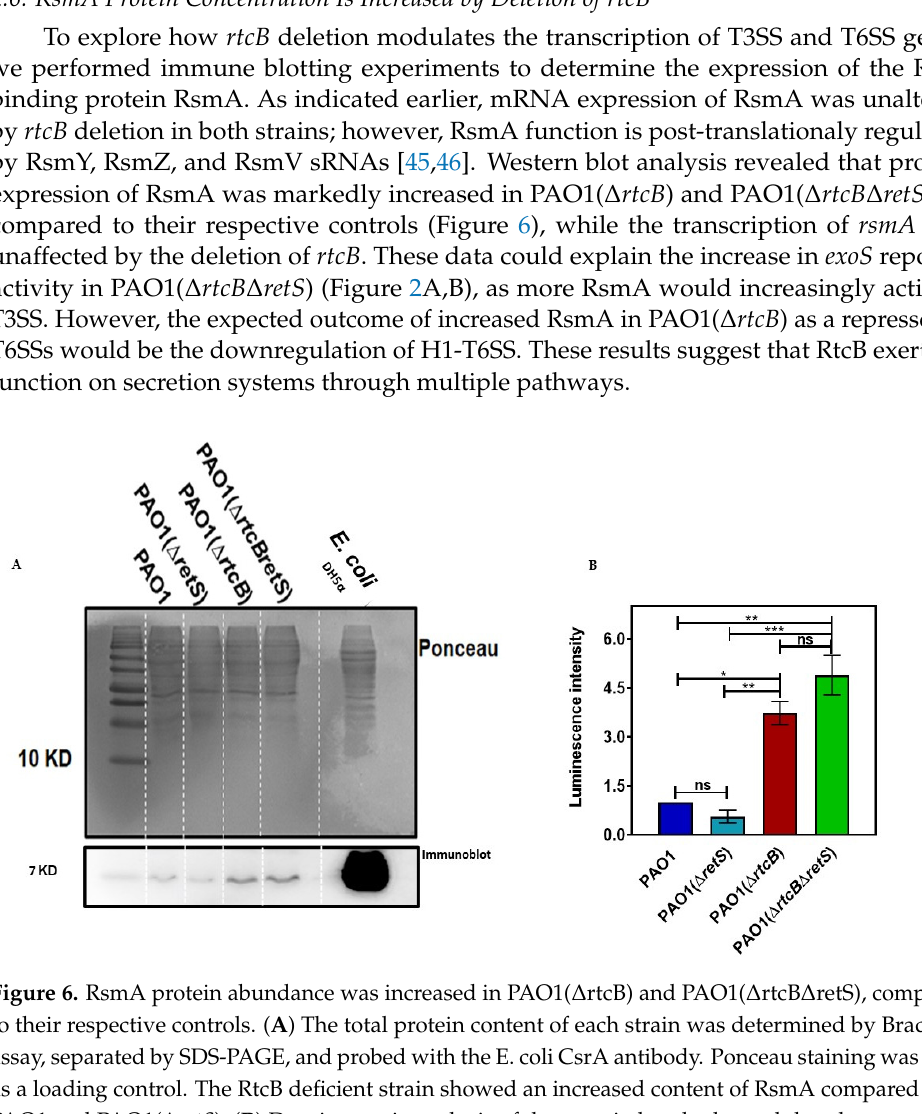
plates. The blue color represents live E. coli cells. The table shows the colony forming unit (CFU) at 10 − 5 , 10 − 4 , and 10 − 3 dilutions. Lower CFU of live E. coli cells (blue colonies) in co-cultures of PAO1( ∆ rtcB )+ E. coli , in comparison with co-cultures of PAO1+ E. coli strains, represent the higher killing potential of PAO1( ∆ rtcB ) with activated T6SSs. ( C ) Fluorescence competition assay showing live E. coli harboring pilG -DsRed fluorescent reporter in red. ( D ) Photographed lettuce midribs show the infection sites after 48 h. PAO1( ∆ rtcB ) and PAO1( ∆ rtcB ∆ retS ) caused a more robust infection than PAO1 and PAO1( ∆ retS ), respectively.